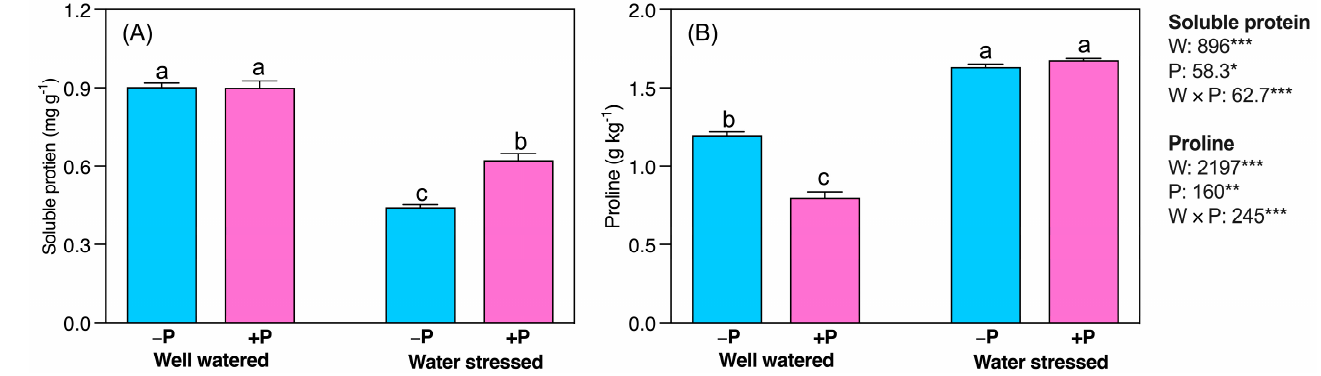
Figure 4. Changes inconcentrations of ( A ) soluble protein and ( B ) proline in response to P supplementation, under well-watered and drought-stressed conditions. A different letter following the means indicates significant differences ( p < 0.05) between the four treatments, as determined by Duncan’s test. Bars represent means ± SD. An overview of the two-way ANOVA assessing the effect of water (W) and phosphorus (P) treatments is presented in the right-hand corner of each panel. *, ** and *** indicate that F values were significant at p ≤ 0.05, 0.01, and 0.001, respectively.